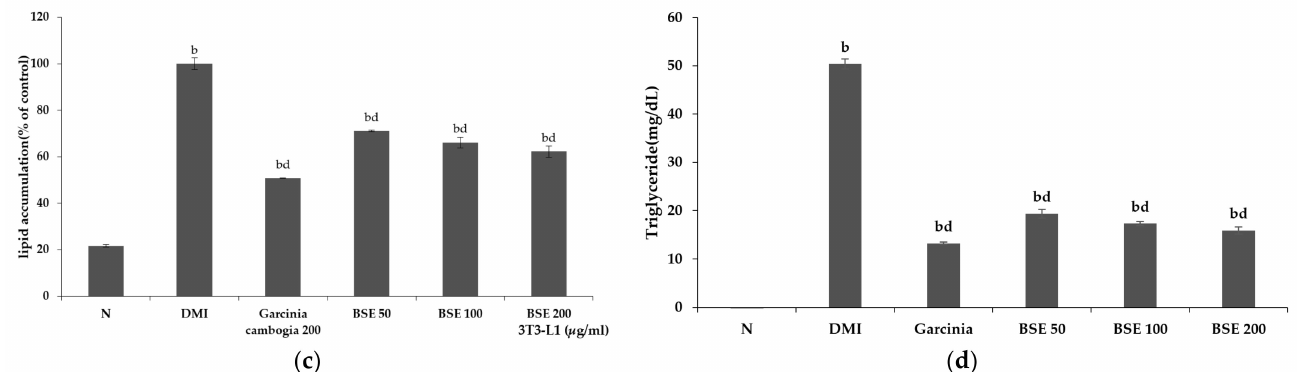
Figure 2. Differentiation inhibitory effect of BSE on 3T3-L1 cells. ( a ) Cytotoxicity through WST-1 assay on 3T3-L1 cells of BSE. ( b ) Morphological observation of lipid droplets in adipocytes through Oil Red O staining (100 × , Axiovert 100, Oberkochen, Germany). ( c ) Oil Red O staining levels obtained by measuring absorbance at 500 nm with 100% isopropanol. ( d ) Measurement of intracellular triglyceride content. Statistical analysis was performed using a t -test. b p < 0.01 compared with Group N. d p < 0.01 compared with the DMI group. N: no substance treatment; DMI: 1 µ M dexamethasone, 0.5 mM 3-isobutyl-1-methylxanthine, and 1 µ g/mL of insulin; Gar: DMI + Garcinia cambogia; BSE: DMI + barley sprout hot-water